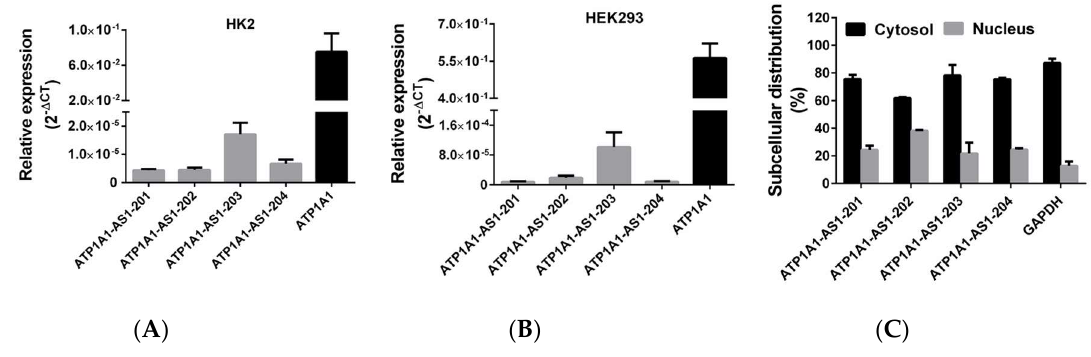
Figure 2. Differential expression and subcellular distribution of ATP1A1-AS1 splice variants in human kidney cells. ( A ) Expression of four splice variants of ATP1A1-AS1 and messenger RNA (mRNA) level of ATP1A1 in human adult kidney cells (HK2 cells). ( B ) Expression of ATP1A1-AS1 splice variants and ATP1A1 in human embryonic kidney cells (HEK293 cells). ( C ) Distribution of ATP1A1-AS1 splice variants in cytosol and nuclear fraction of HK2 cells. GAPDH mRNA was used as cytoplasmic control RNA. These experiments were repeated four times.